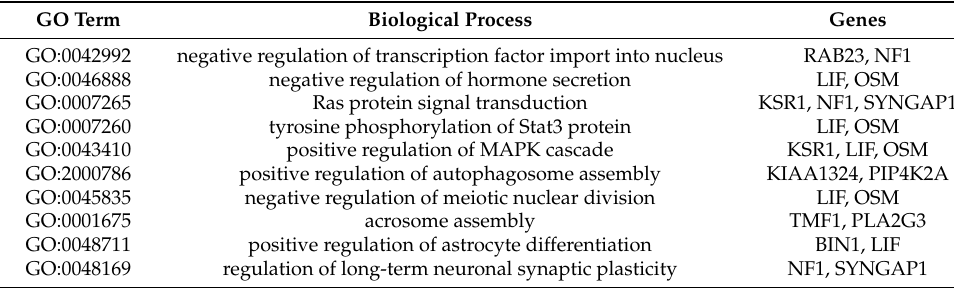
Table 5. Genes associated in biological processes by DAVID